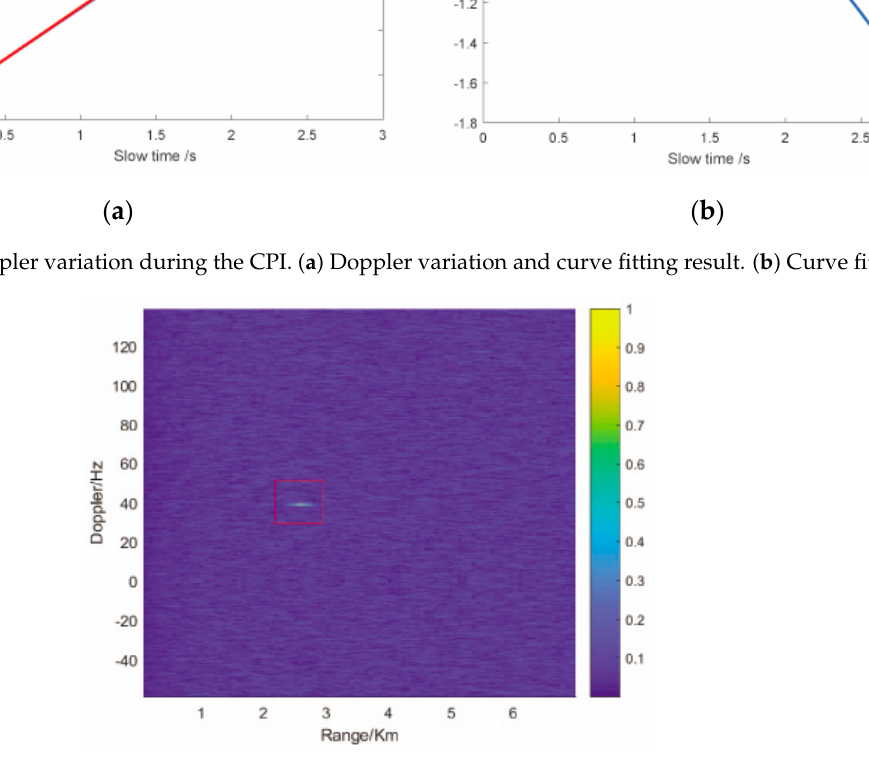
(b) Figure 14. Doppler variation during the CPI. ( a ) Doppler variation and curve fitting result. ( b ) Curve fitting error.